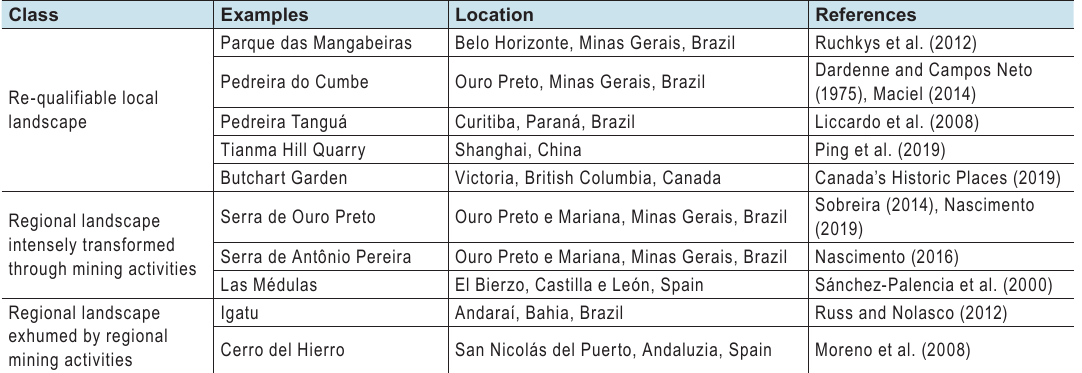
TABLE 1 . Types of landscapes modified by mining and